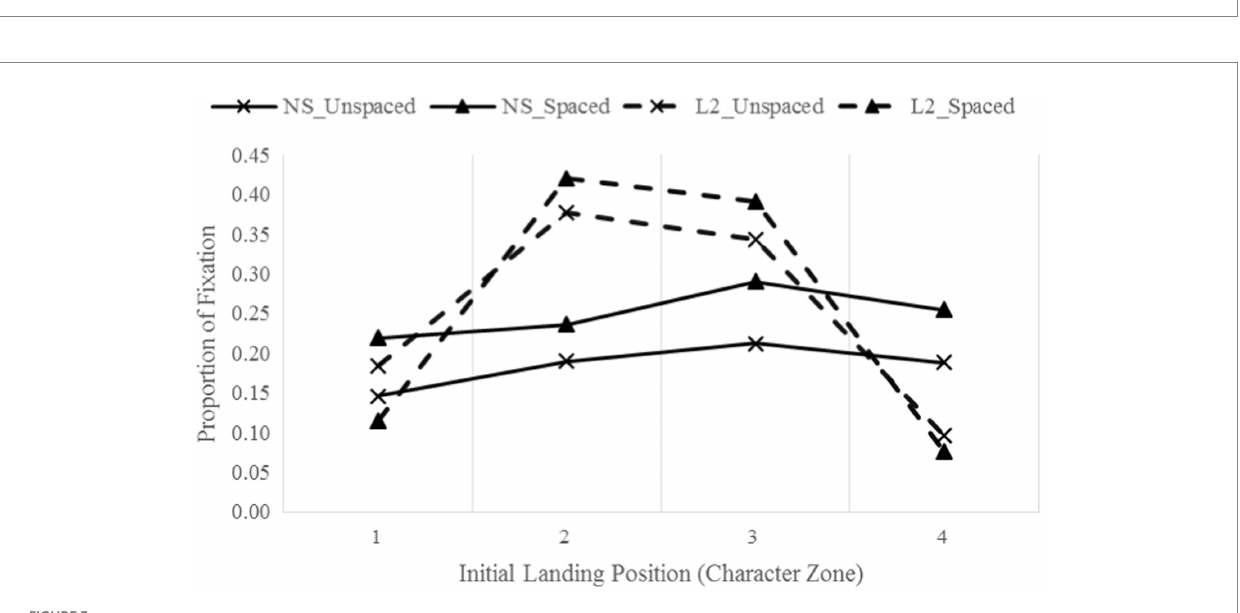
FIGURE 2 The distribution of landing positions of initial fixations.